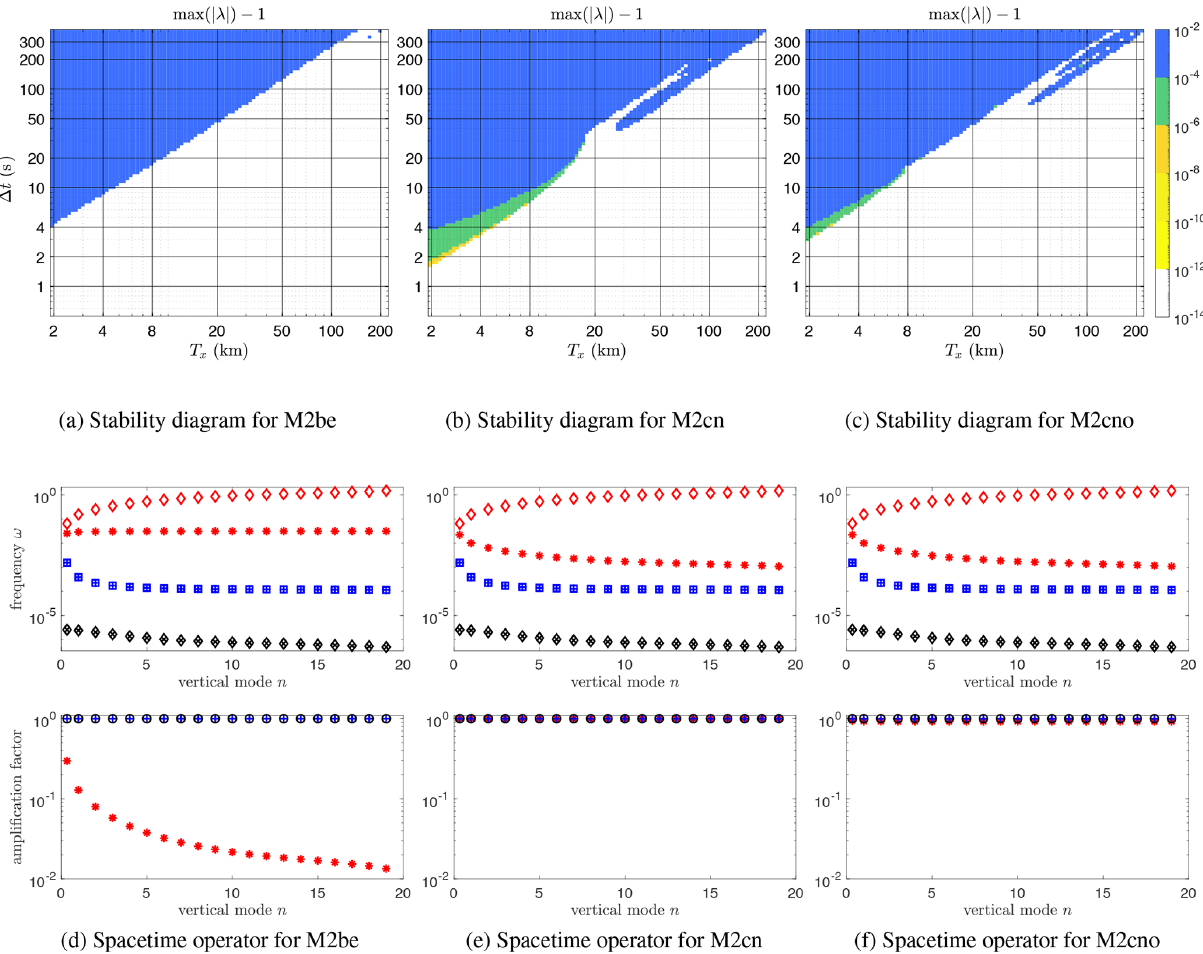
Figure 5. Properties of M2 schemes: stability, dispersion, and dissipation